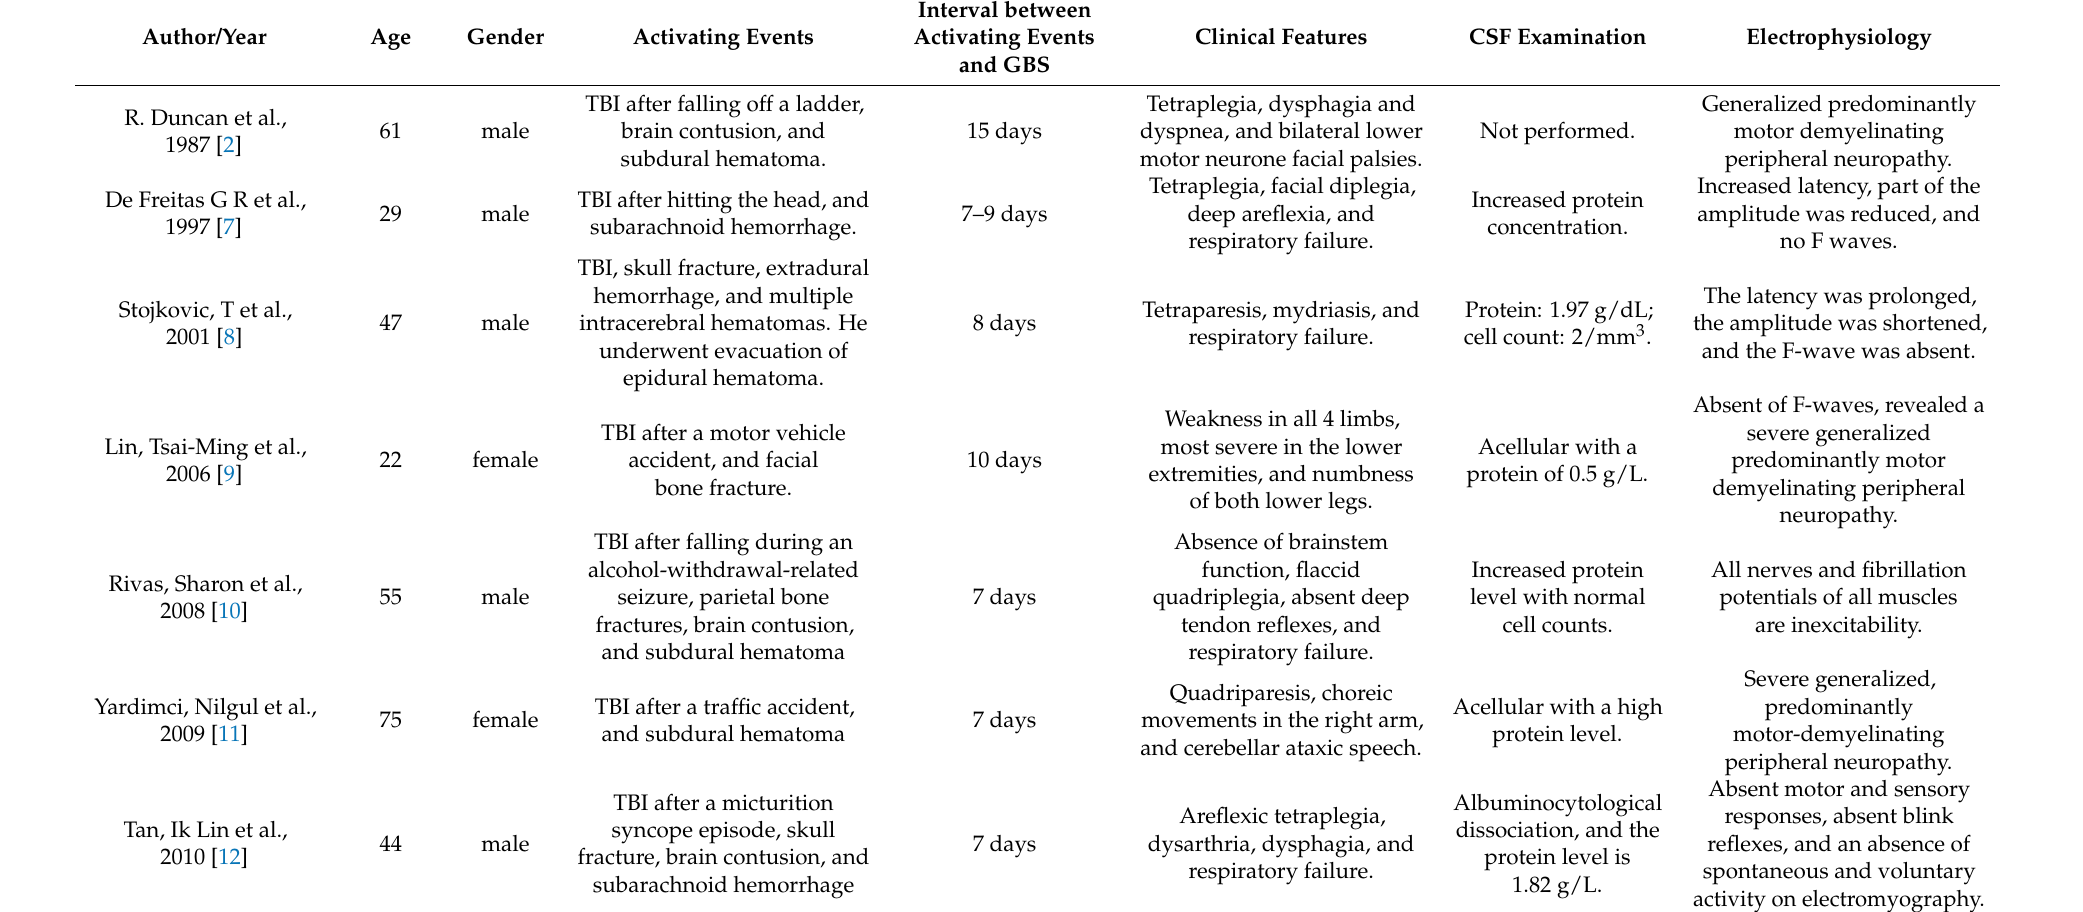
Table 2. Summary of the reported cases with Guillain-Barr é syndrome after traumatic brain